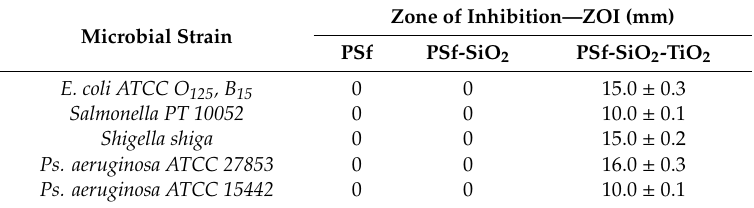
Table 6. The antimicrobial action of the tested membranes determined through a disk-diffusion technique.